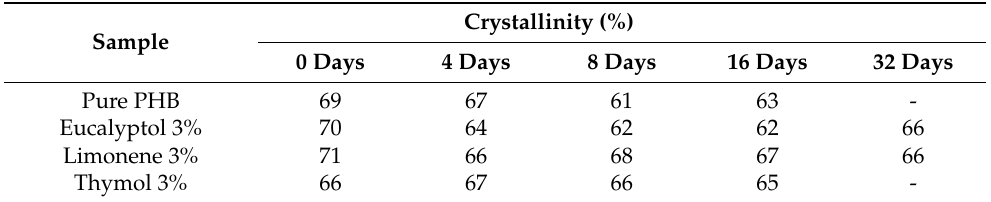
Table 1. DSC: Crystallinity (second heating).